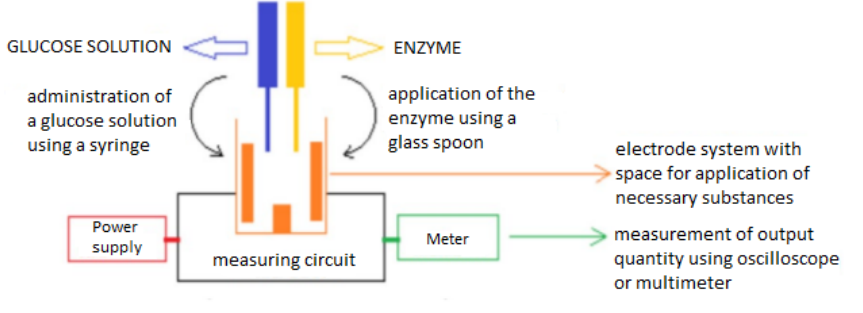
Figure 1. Electrode measuring system.